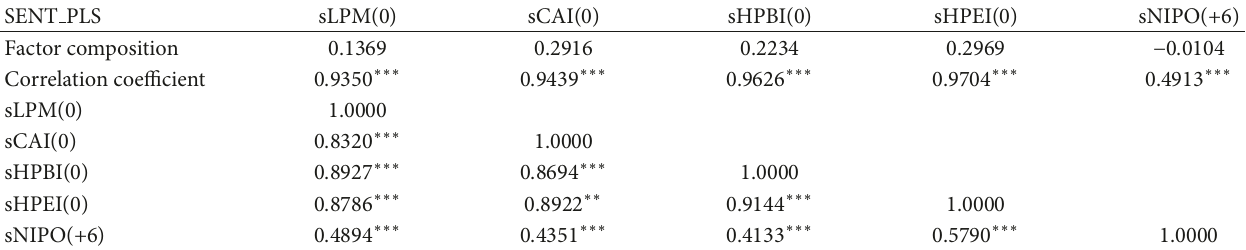
Table 3: The correlation between the comprehensive measure index of investor sentiment (PLS) and proxy